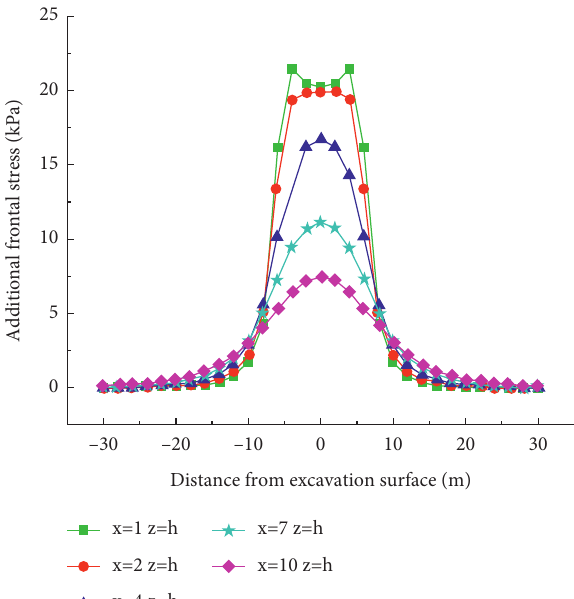
Figure 7: The distribution of the additional stress σ axis.